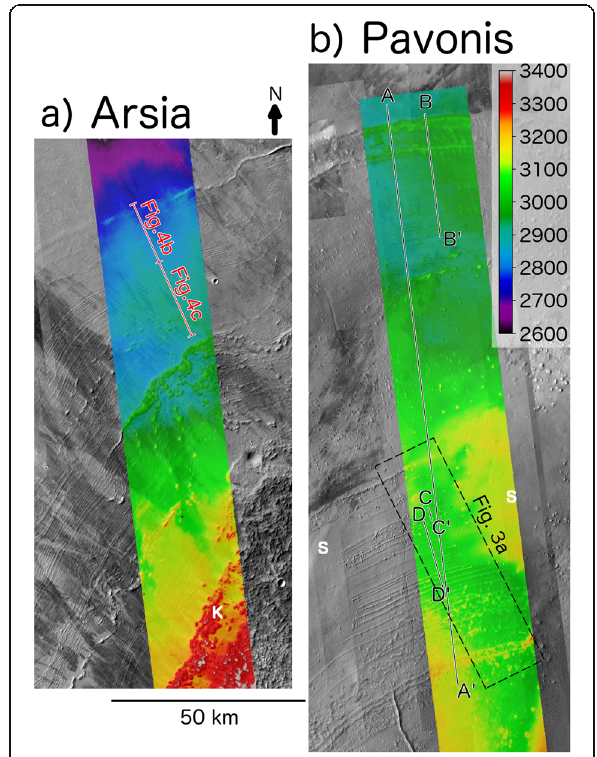
Fig. 2 Topography and morphology of the distal portion of the Arsia ( a ) and Pavonis ( b ) FSDs. CTX imagery and transparent stereo topography (colored regions) shows ridge sequences of parallel ridges together with smooth (labeled with “ S ” ) and knobby (labeled with “ K ” ) units. The smooth unit (interpreted as remnant debris- covered ice by Shean et al. 2005) superposes ridges in the Pavonis FSD and indicates that the flow of ice responsible for forming the smooth unit was not erosive. Ridge spacing and cross-sectional area measurements using this data are shown in Figs. 3 and